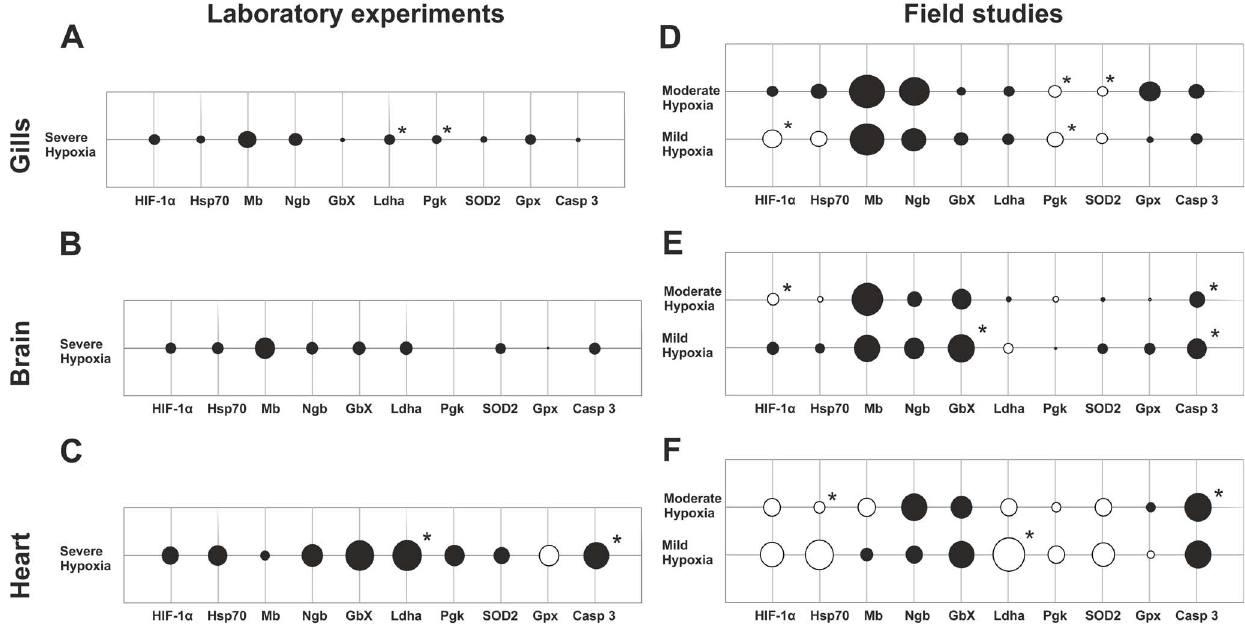
Figure 4. Bubble charts of relative expression patterns of putatively hypoxia responsive genes in flounder under severe hypoxic conditions in laboratory experiments (A, B and C) and different hypoxic conditions in the Elbe estuary (C, D and E). Evaluation of qRT- PCR results was performed with DD CT method by use of RPLP0 as a reference gene. All results of relative expression levels are represented in log base 2. The diameter of bubbles indicates the magnitude of gene expression. Black bubbles represent expression levels . 0, pen bubbles represent expression levels , 0, and crossing lines without a bubble signify no change in the expression level. Asterisks indicate significance at p , 0.1. We analysed the expression pattern in three tissues of flounder: (A) and (D) gills, (B) and (E) brain and (C) and (F) heart. For more details see Table S2.